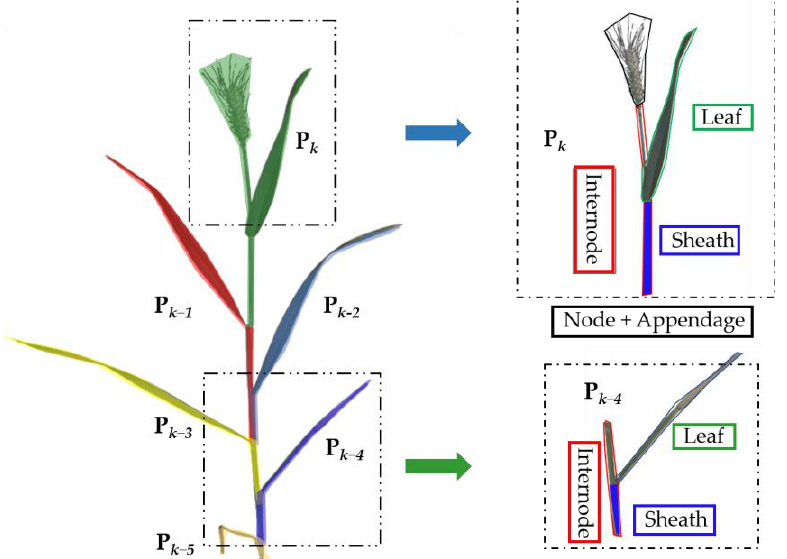
Figure 3. Schematic of the definition of wheat phytomers. Wheat phytomers include leaf blade (green box), leaf sheath (blue box), and node attached to the leaf sheath and appendages on the node (red box). 𝑃 𝑘 represents the phytomer with wheat ears; P k − 4 represents the interdigitated phytomer.